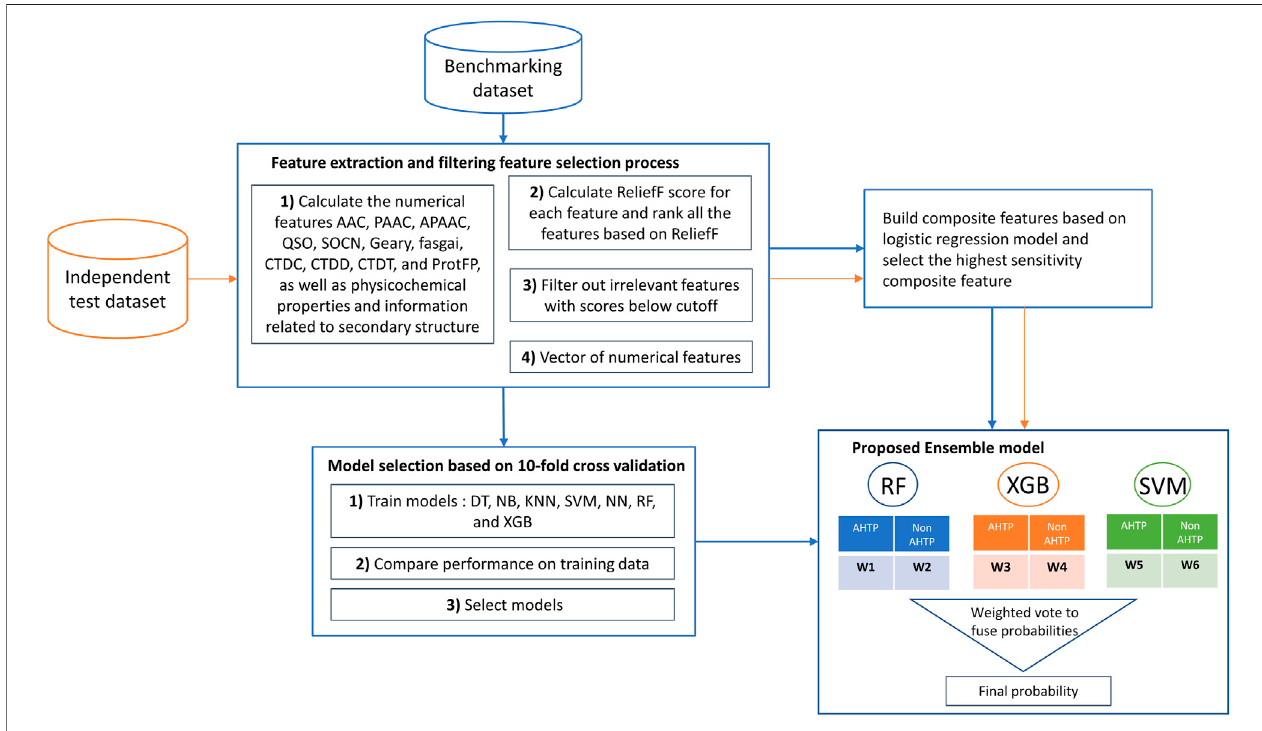
FIGURE 1 | Work fl ow of the proposed